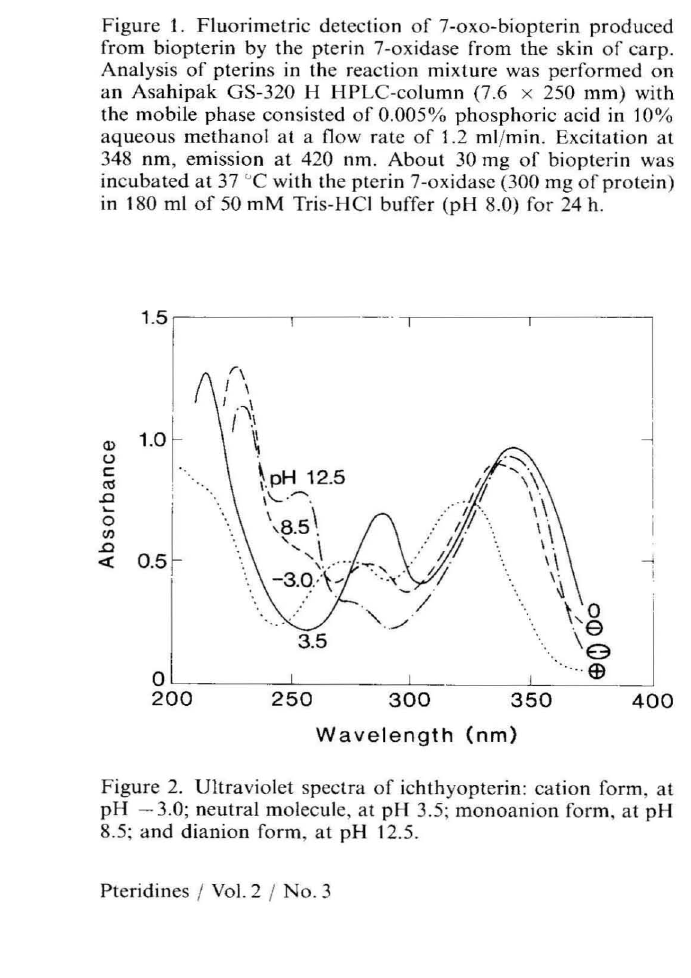
Table 2. Retention times of pteridines on HPLC columns. Pter idincs were analyzed by each column (4.6 x 250 mm)